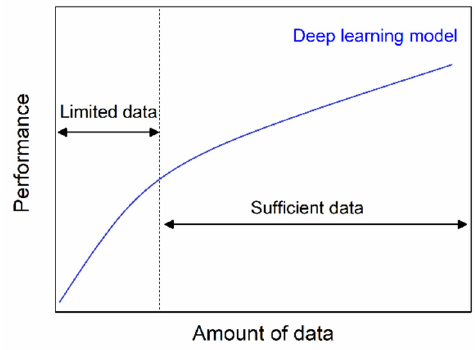
Figure 1. The relationship between performance and data volume.